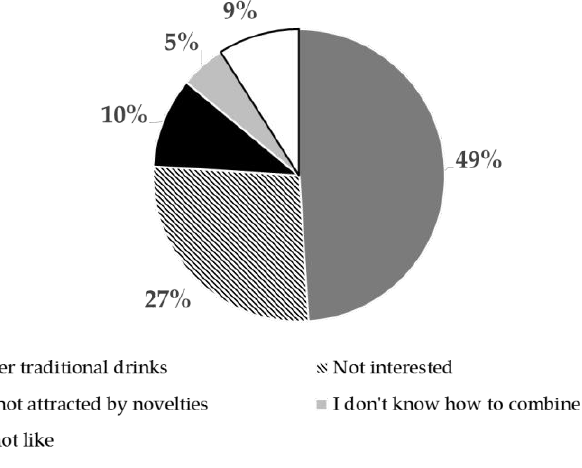
Figure 2. Consumers’ motivations for not consuming fruit wines ( n = 119). Table 1. Consumption habits of alcoholic beverages for new entries ( n = 253) and neophiles ( n = 118). Product